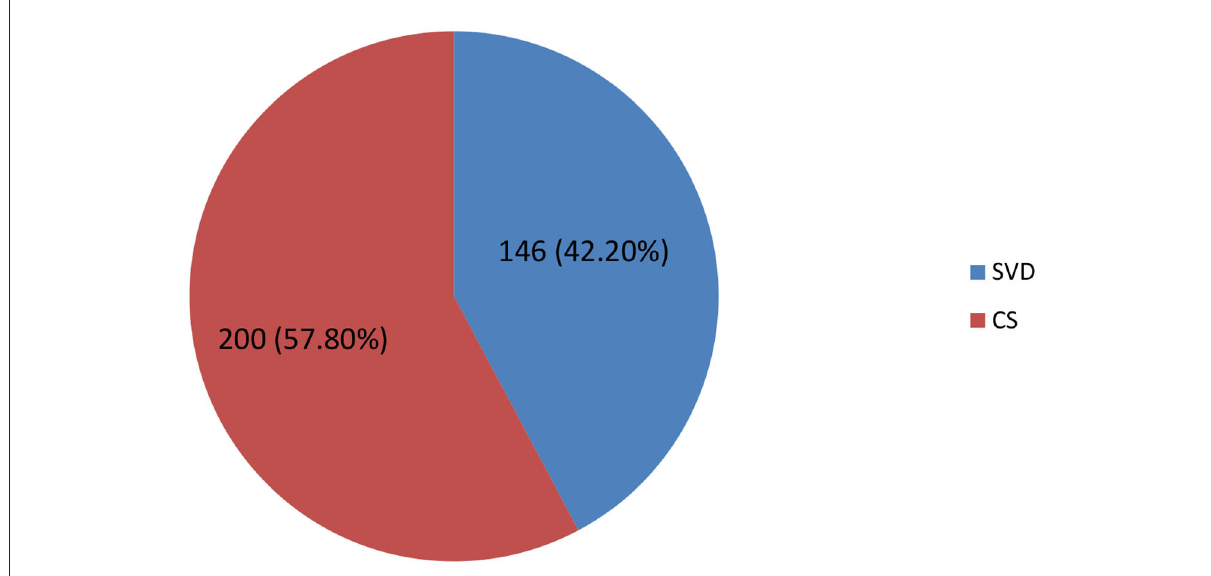
FIGURE1 Mode of delivery among diabetic mothers at the Tikur Anbessa Specialized Hospital in Addis Ababa, Ethiopia, 2018.